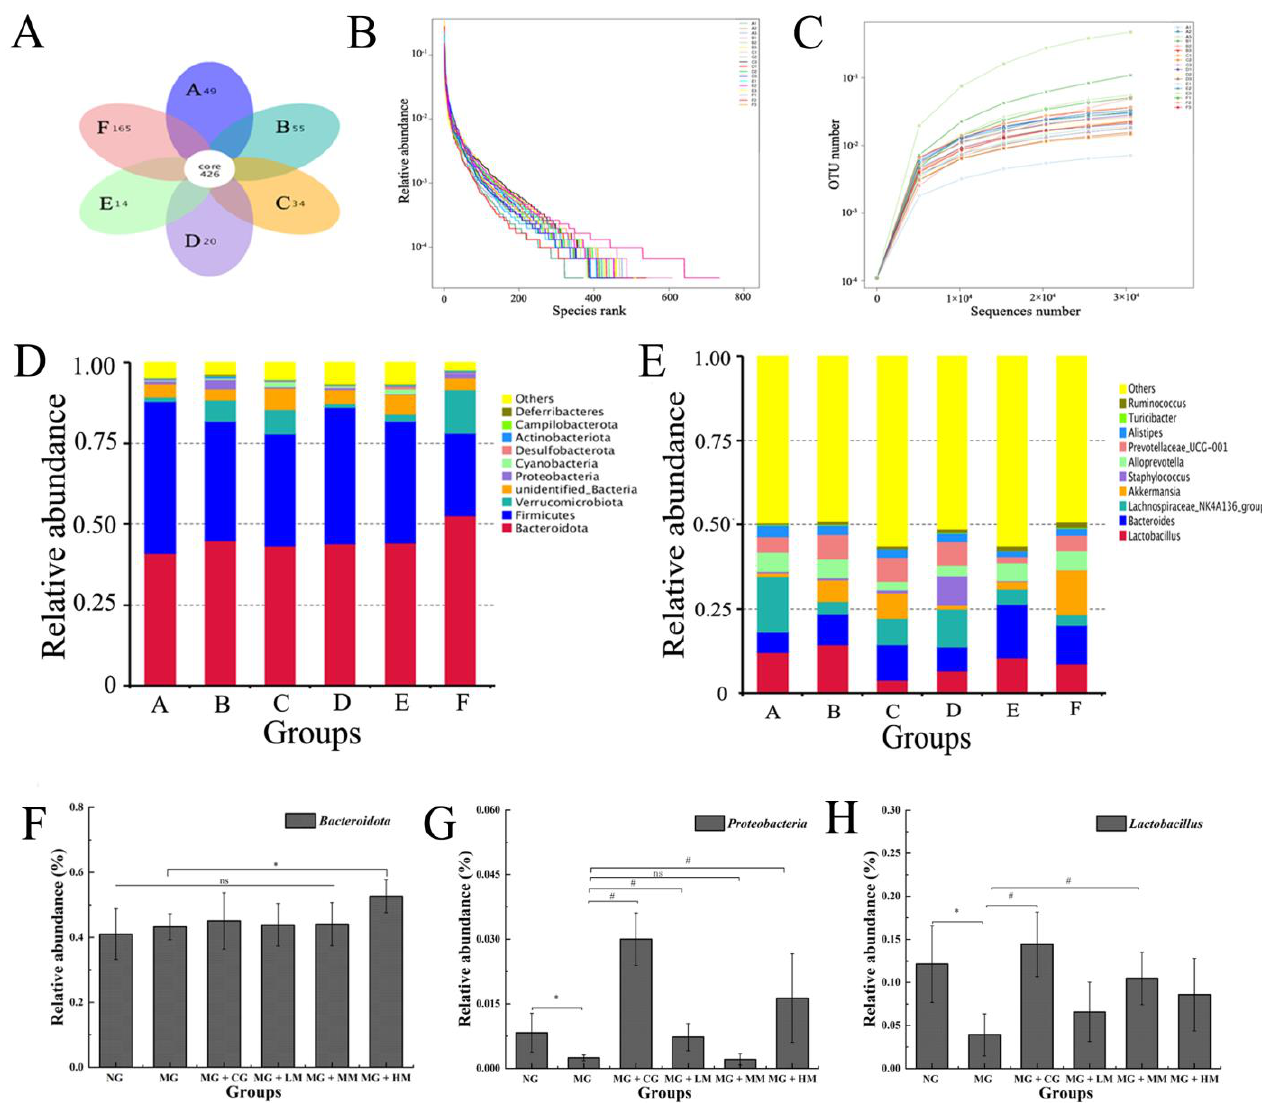
Figure 6. Impact of MRJP administration on intestinal microbiota in cyclophosphamide-induced mice. ( A ) The effect of MRJPs on the number of intestinal microbes OUT — A. NG; B. MG + CG; C. MG; D. MG + LM; E. MG + MM; and F. MG + HM; ( B ) rarefaction curve; ( C ) OTU rank curve of fecal DNA samples; ( D ) relative abundance of microbes in phylum; ( E ) relative abundance of microbes in genus; ( F ) relative abundance of Bacteroidota ; and ( G ) relative abundance of Proteobacteria . ( H ) relative abundance of Lactobacillus .The different letters above each bar indicate statistically significant differences ( p <